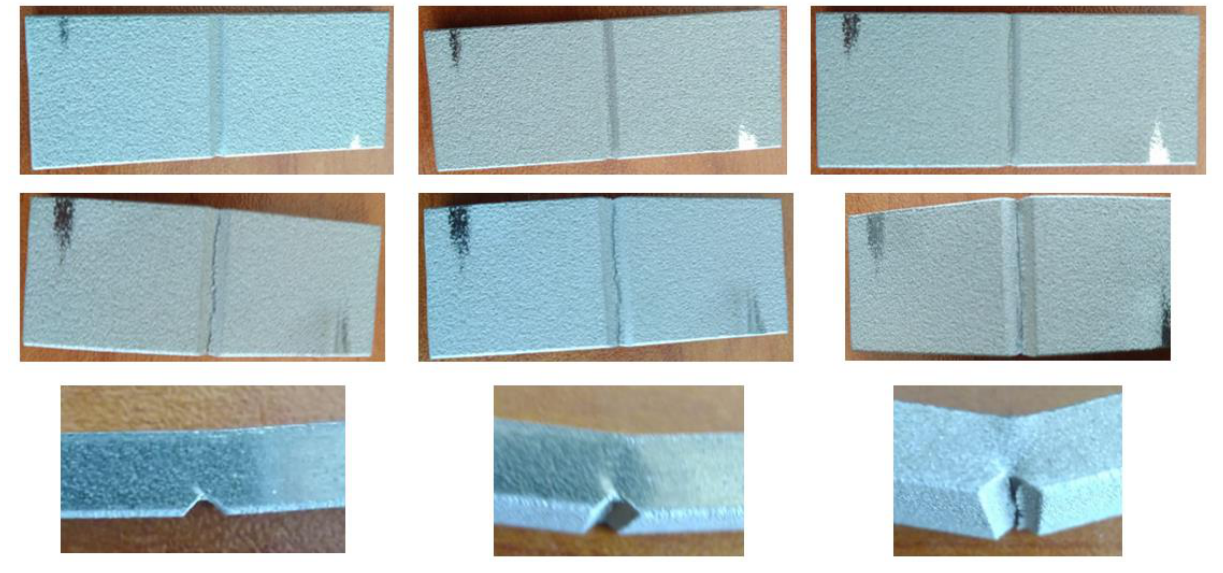
Figure 11. Coating behavior for different bending cycles at the maximum stroke of 1.2 mm. The crack was confined at the notch tip and continued to grow as the number of loading cycles increased.